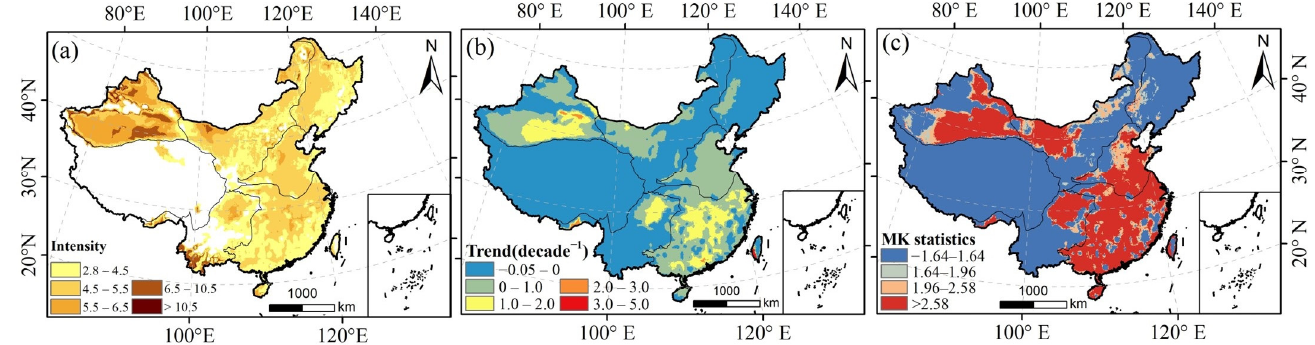
Figure 9. The spatial distribution of ( a ) different intensities of heatwave events, ( b ) interannual change trend, and associated ( c ) Mann–Kendall statistics.